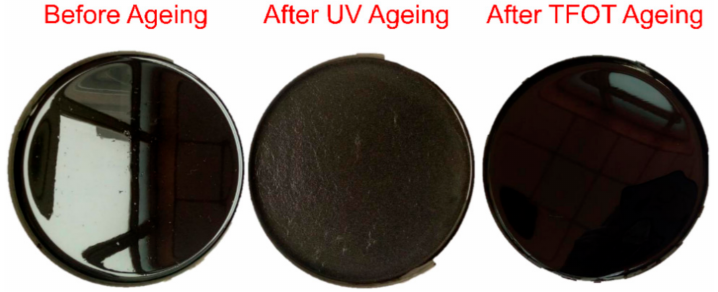
Figure 1. The plate with bitumen before and after